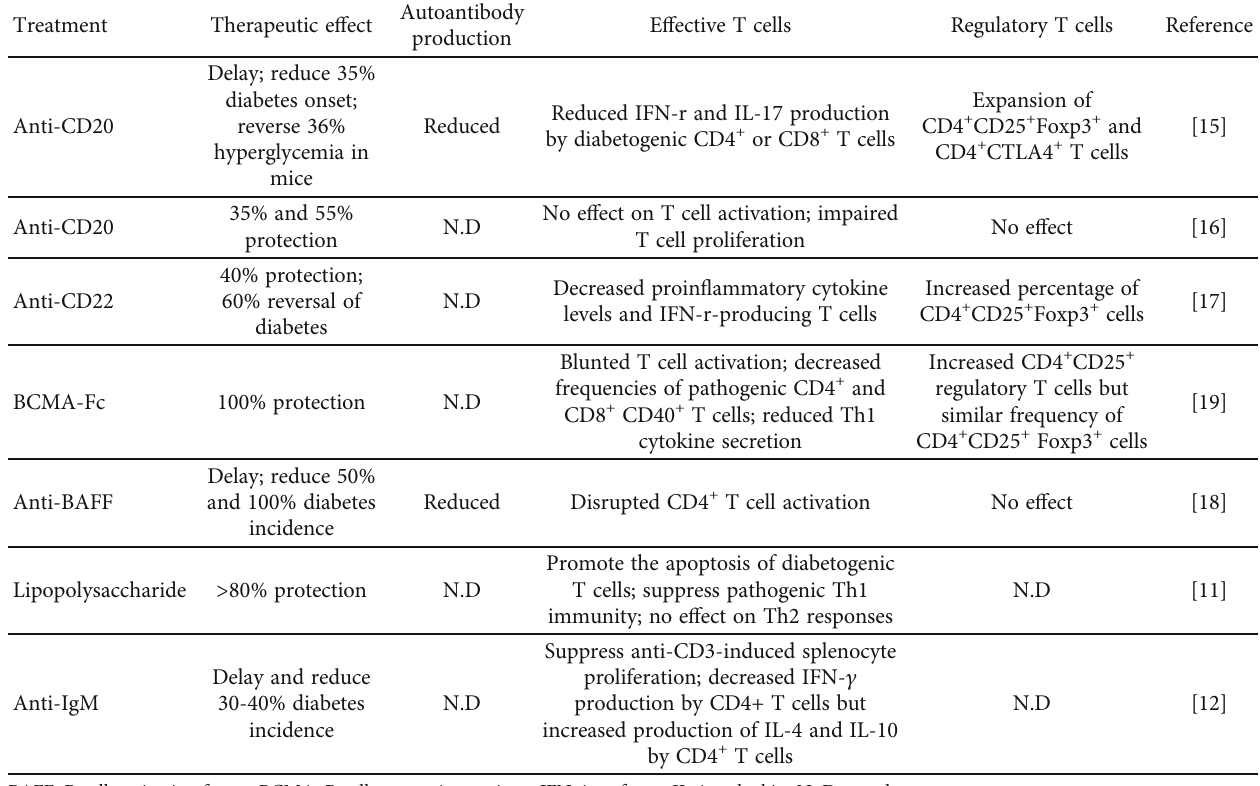
Table 1: The double e ff ect of B cells on e ff ective and regulatory T cells in nonobese diabetic mice.